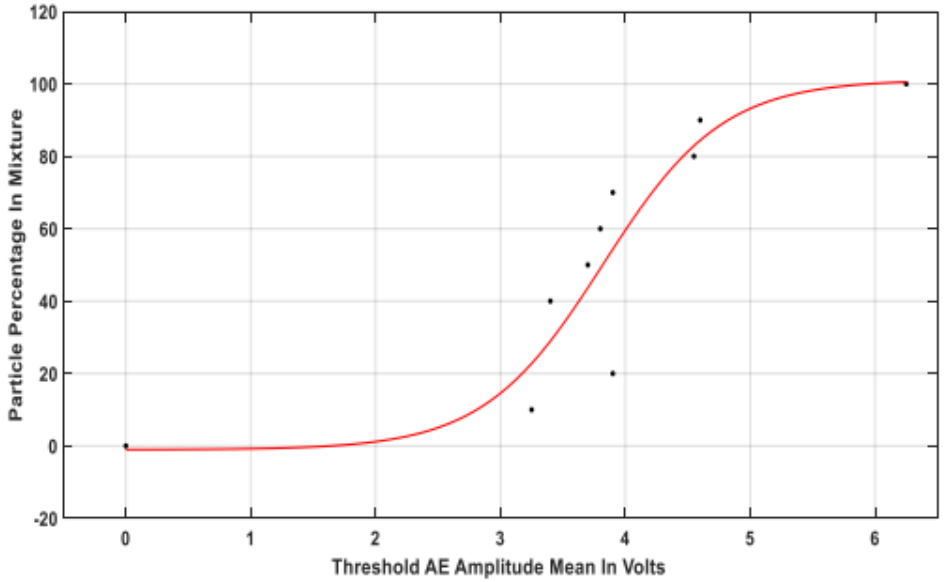
Figure 12. Resulting regression model from optimal threshold region [27]. It can be noted that each point along the curve was produced with five experimental repetitions, each of which have been averaged out to produce a single point.